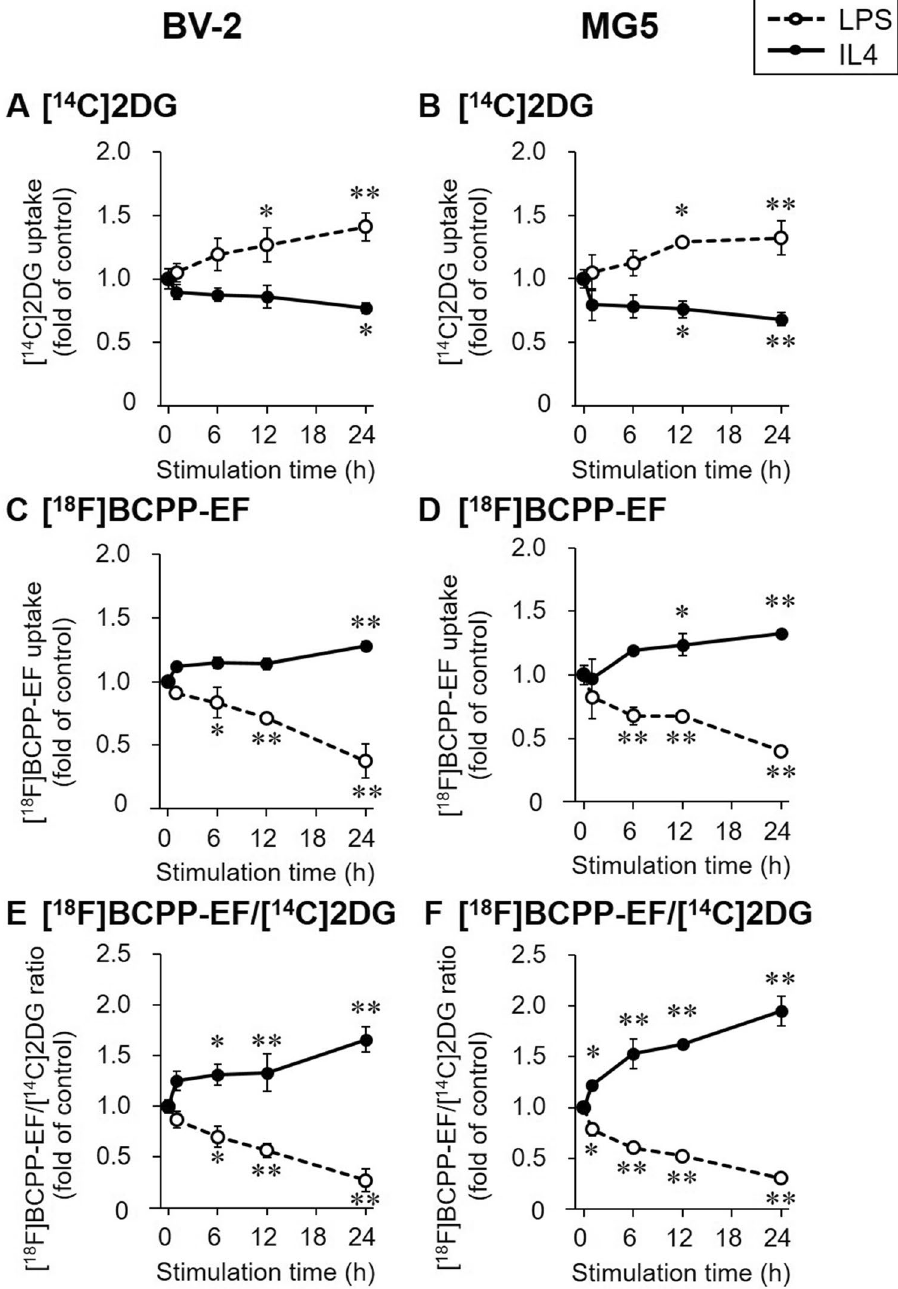
Figure 5. [ 14 C]2DG and [ 18 F]BCPP-EF uptake profiles. Cellular uptake of [ 14 C]2DG ( A and B ) and [ 18 F] BCPP-EF ( C and D ) was determined in LPS (1000 ng/mL, open circle and dashed line)- or IL4 (60 ng/mL, closed circle and solid line)-stimulated BV-2 and MG5 cells, and the ratio of [ 18 F]BCPP-EF uptake to [ 14 C]2DG uptake ([ 18 F]BCPP-EF/[ 14 C]2DG ratio, E and F ) was calculated. The results are presented as the fold change in uptake or the uptake ratio relative to the control group (0 h stimulation) and the means ± SDs of three samples. Statistical differences were analyzed by ANOVA followed by Dunnett’s multiple comparison test; * p < 0.05, ** p < 0.01 compared with the